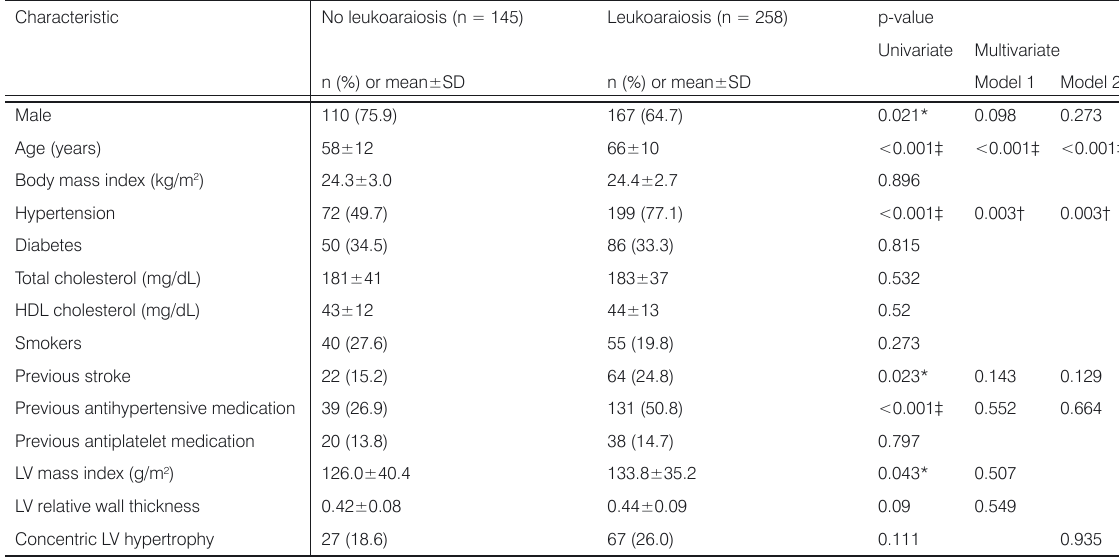
Model 1 was used to examine the relations of LV mass index and relative wall thickness as continuous independent variables to a dichotomous dependent variable. Model 2 was used to examine the relation of LV geometry as a categorical independent variable to a dichotomous dependent variable. LV mass index and LV geometry were analyzed separately because of their colinearity. Variables were selected for entry into the multivariate models based on the results of univariate analyses (p<0.15).